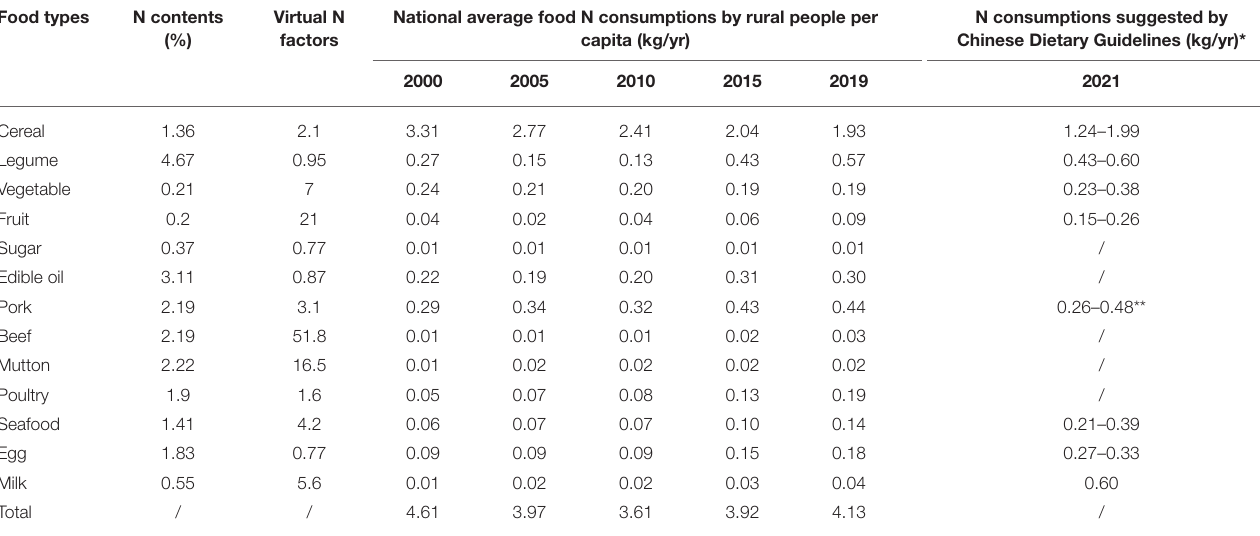
TABLE 1 | Average per capita food nitrogen (N) consumptions by rural people from 2000 to 2019, and ranges of national recommended N intake. Food types